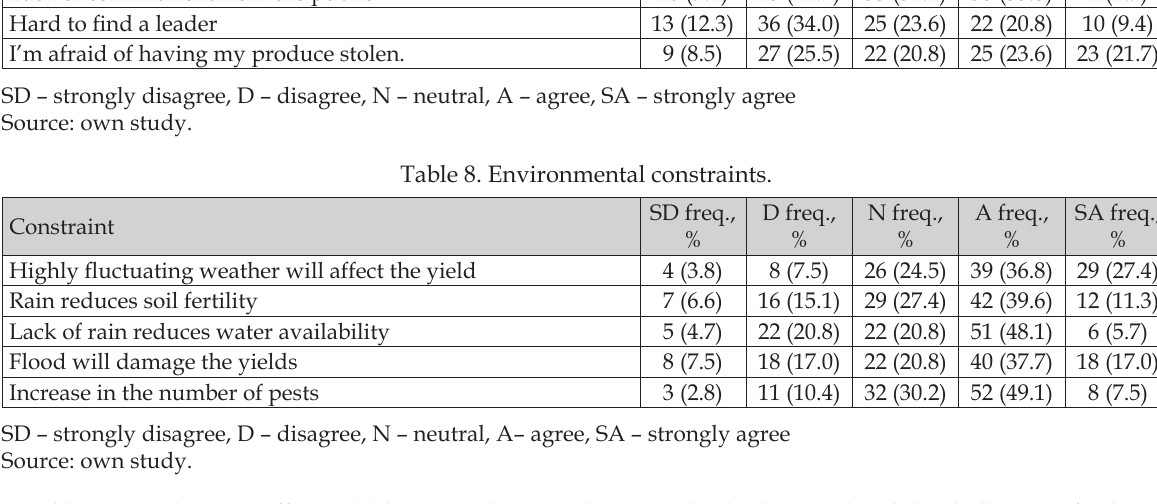
Table 9. Correlation coefficient (r) between the socio-demographic background and the challenges of